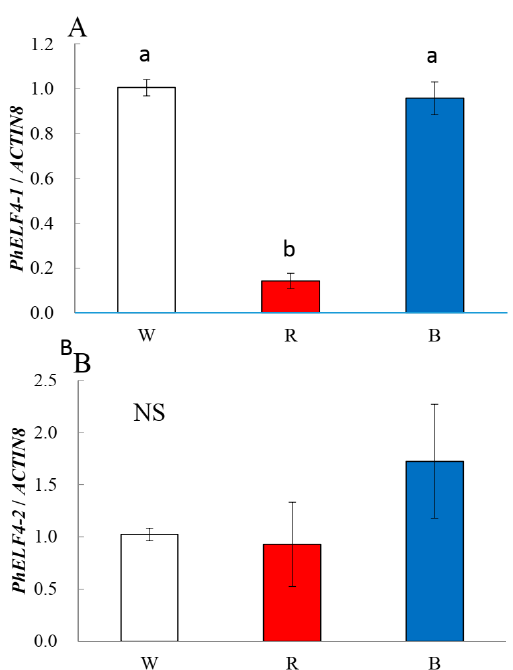
Figure 2. Expression of PhELF4-1 ( A ) and PhELF4-2 ( B ) in young leaves of petunia, grown under white fluorescent light (W) or blue (B) or red (R) light from light emitting diodes, as analyzed by real-time quantitative PCR. Thamples were harvested 12 h into the 14 h photoperiod on the second day of the treatments and the expression was normalized to the expression of the PhACTIN 8 gene and shown as mean values relative to the mean value for the W light treatment. The error bars show standard errors ( n = 3), and di ff erent letters within the same column show significant di ff erences among treatments using ANOVA glm followed by Tukey pairwise comparisons ( p < 0.05). NS = no significant di ff erence between treatments.